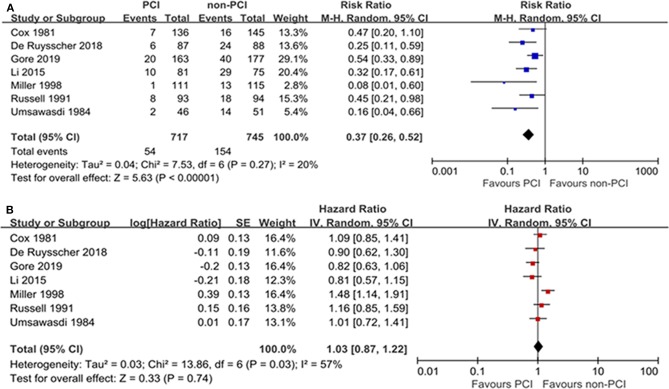
Forest plots of relative ratio (RR) on brain metastasis (A) and hazard ratio (HR) on overall survival (B).